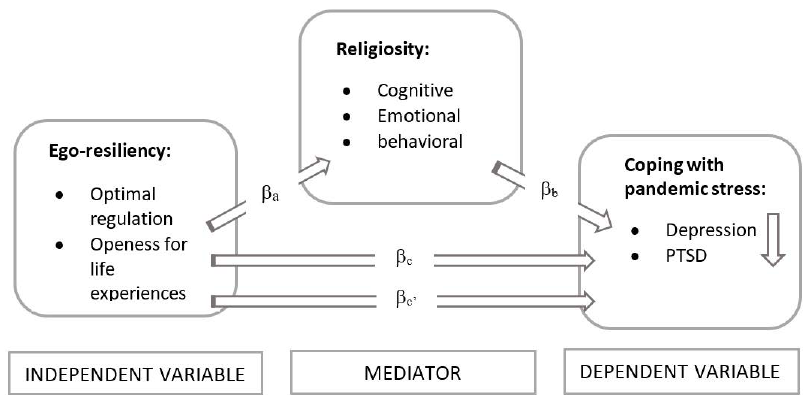
Figure 1. Theoretical model of the ego ‐ resiliency–religiosity–coping connections.